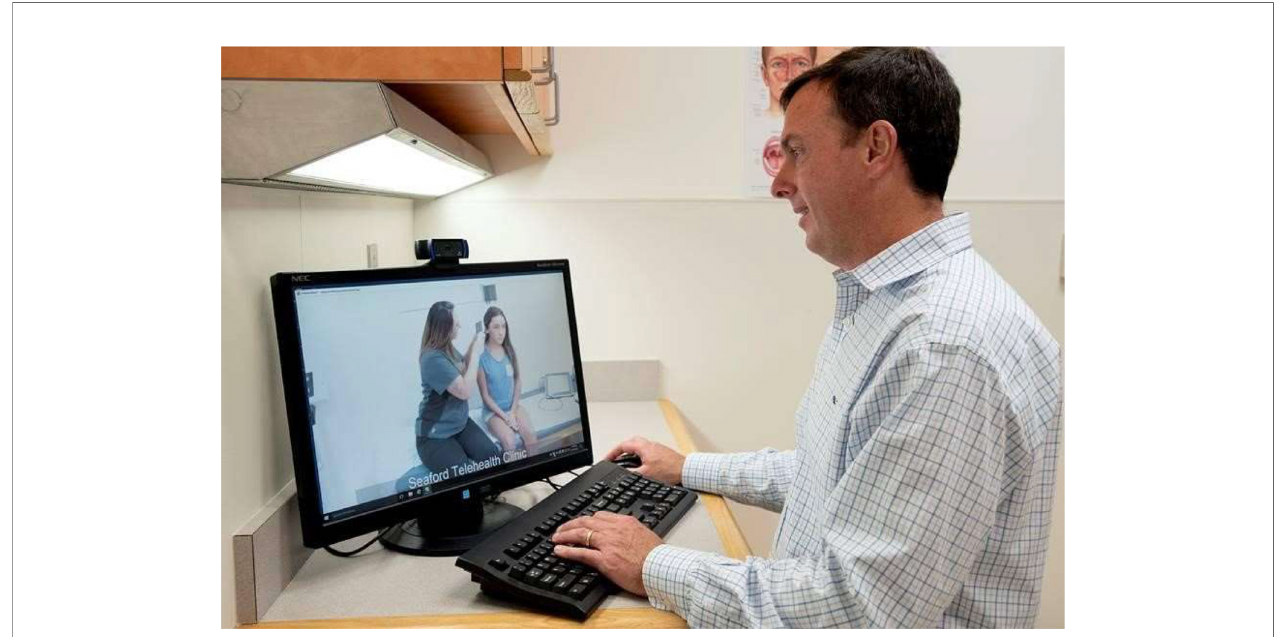
FIGURE 1 | Medical assistant telemedicine in use. A physician provider to the far right is watching the medical assistant at the far left on the screen using a device to examine the ear of a patient. The device will relay images of the patient ’ s ear exam to the physician (Photo used with permission of A. Saporito. Image courtesy of Dr. Patrick Barth).